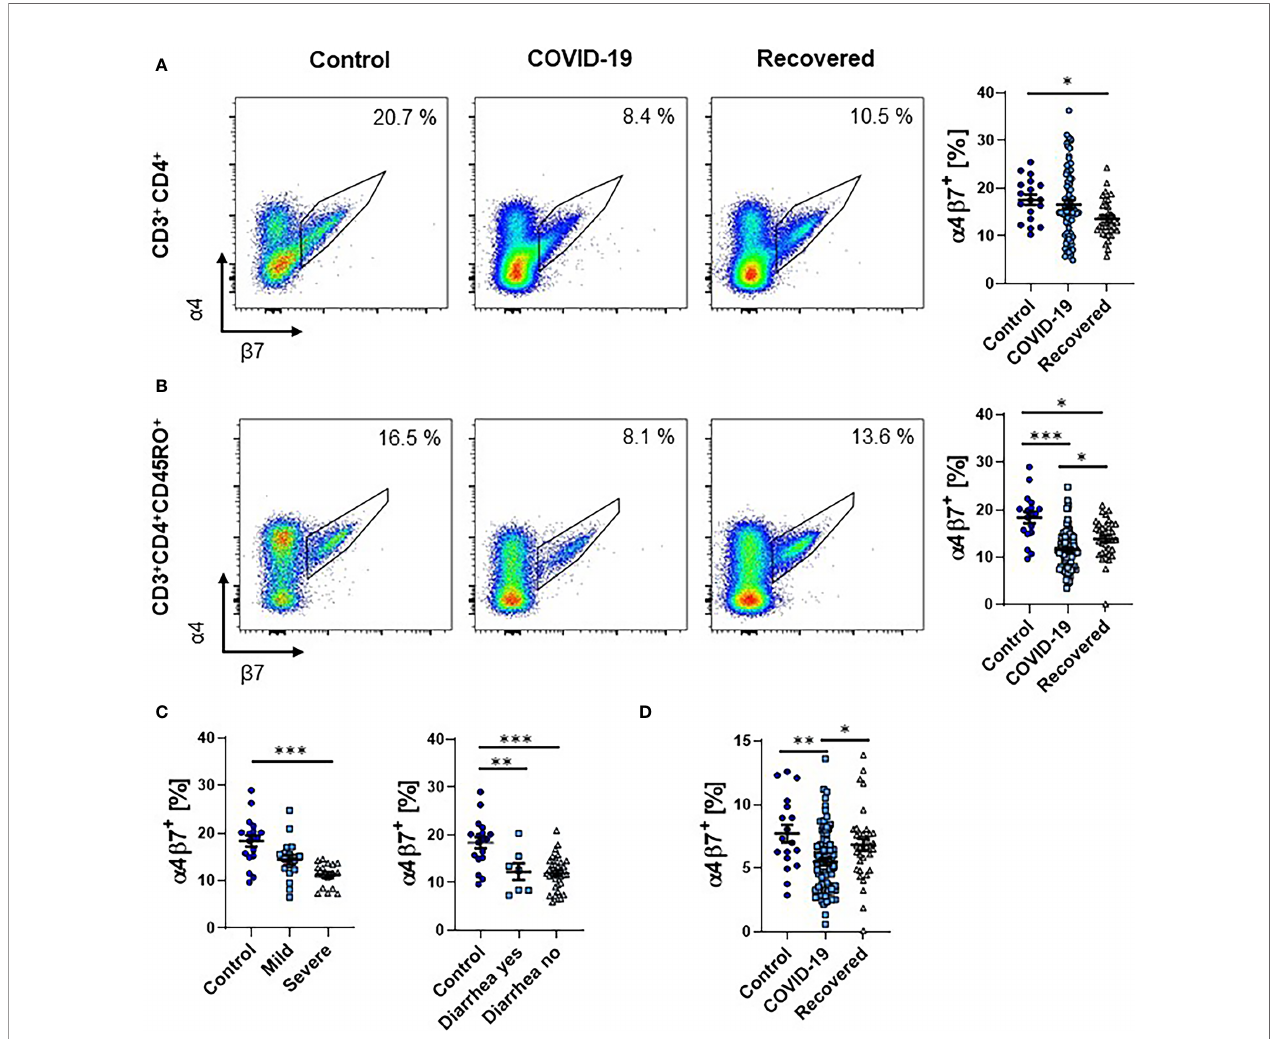
FIGURE 1 | Frequency of a 4 + b 7 + T cells during COVID-19. (A, B) Representative (left) and quantitative (right) fl ow cytometry of the frequency of a 4 b 7 integrin- expressing CD3 + CD4 + T cells (A) and CD3 + CD4 + CD45RO + memory T cells (B) . (C) Quantitative fl ow cytometry of the frequency of a 4 b 7 integrin-expressing CD3 + CD4 + CD45RO + memory T cells in COVID-19 patients with mild or severe disease course (left) and with or without diarrhea (right) compared to healthy controls. (D) Quantitative fl ow cytometry of the frequency of a 4 b 7 integrin-expressing CD3 + CD4 + CD45RO + memory T cells expressed as frequency of CD3 + CD4 + T cells. Each symbol represents an individual subject, n = 7 - 80 per group. *p < 0.05, **p < 0.01, ***p <